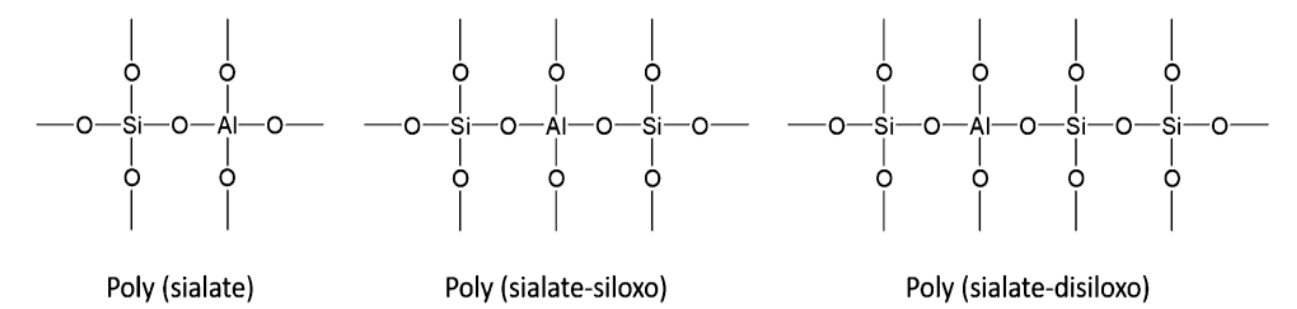
Figure 3. Main polymer chains of geopolymers [61].